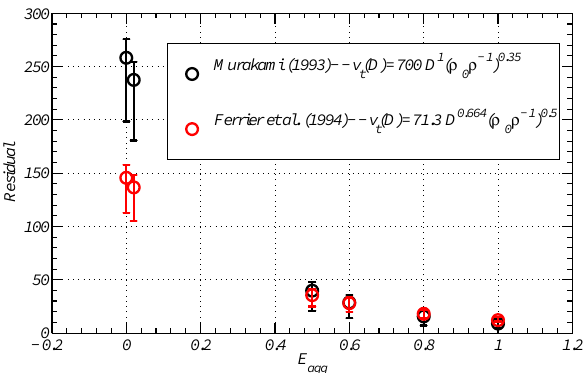
Fig. 15: Values of the residual calculated using Eq. 7 for the Fig. 15. Values of the residual calculated using Eq. 7 for the differ- ent model simulations. Black circles with error bars are for when the different model simulations. Black circles with error bars are terminal velocity relation in Eq. (6) was used in the model, while for when the terminal velocity relation in Eq. 6 was used in red circles are for when Eq. (5) was used. In general this shows the model, while red circles are for when Eq. 5 was used. In that the best agreement is found for higher aggregation efficiencies general this shows that the best agreement is found for higher (i.e. E agg ≥ 0 . aggregation efficiencies (i.e. E agg ≥ 0 . 5 ).